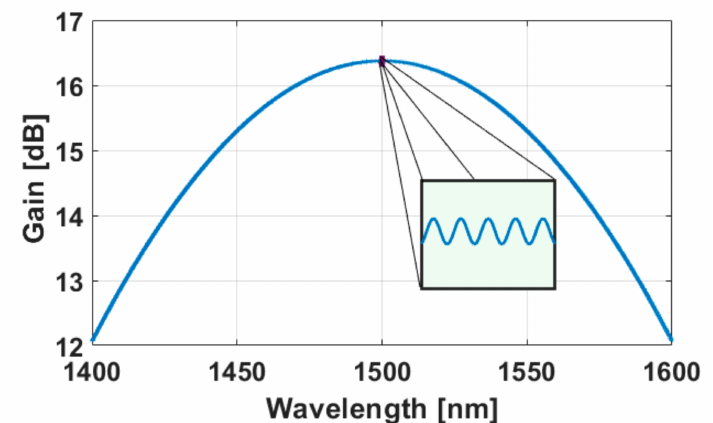
Figure 2. Simulated semiconductor optical amplifier (SOA) gain profile, with inset showing a magnified ripple in the center part of gain profile with gain ripple ( ∆ G ) of 0.3 dB, and FSR ( ∆ λ ) of 0.2